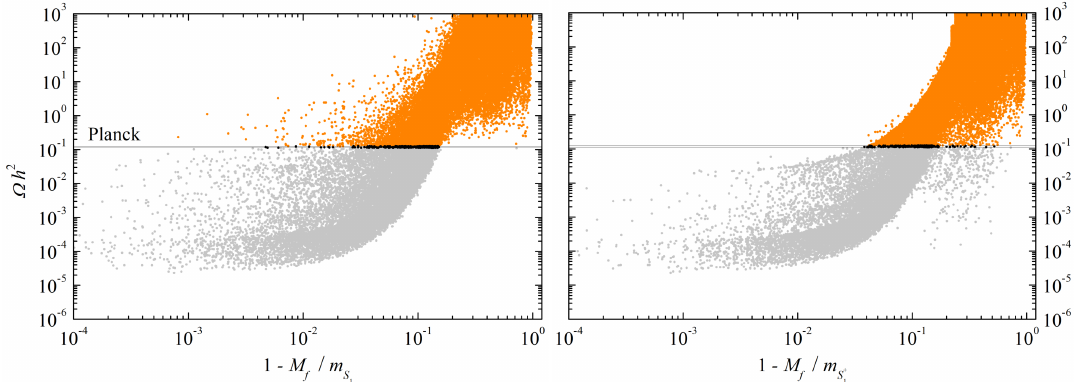
( m ) is shown on the left (right) figure. The S 1 S + 1